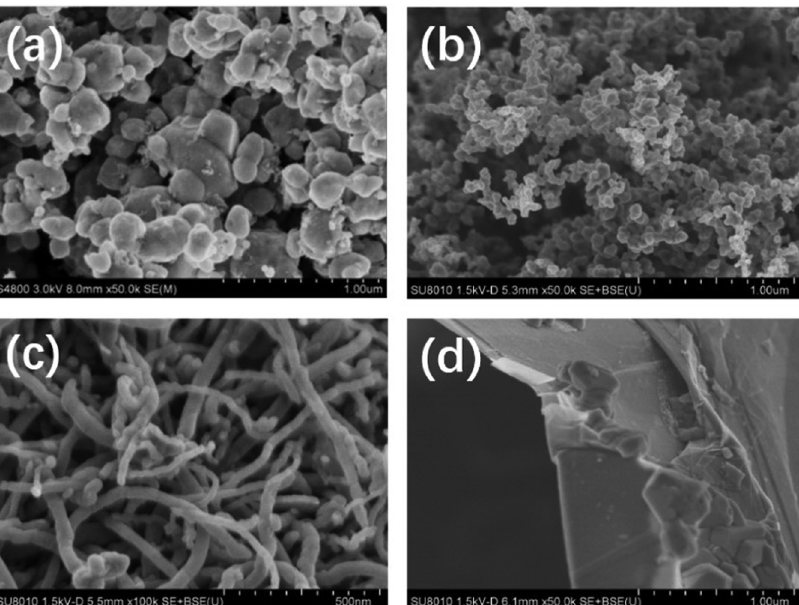
Figure 2: SEM images of LiFePO 4 ( a ) , SP ( b ) , CNTs ( c ) , and GN ( d )